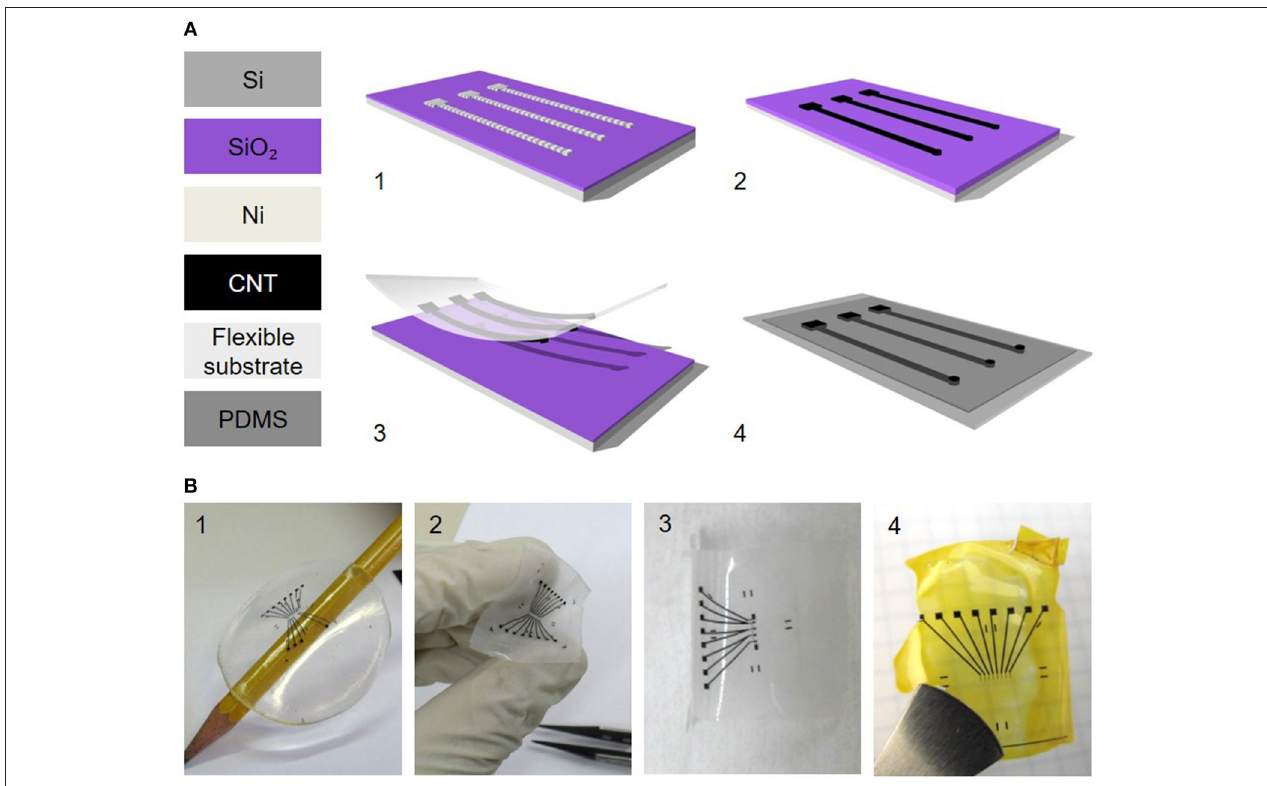
FIGURE 5 | Carbon nanotube-based flexible electrodes for neuronal stimulation. (A) Electrode fabrication scheme. (1) Photolithographically defined Ni catalyst layer. (2) CNT film CVD growth. (3) Film transfer to a polymeric support. (4) A second polymeric layer (PDMS) with predefined holes is bonded with the CNT carrying film for passivation. (B) Different patterns of flexible CNT electrode arrays on different support layers: (1) PDMS, (2) medical adhesive tape, (3) parylene C and (4) polyimide (125). Adapted from David-Pur et al. (125). Copyright 2013, the